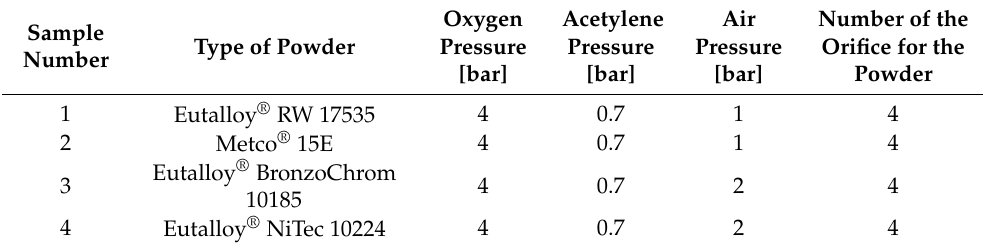
Table 6. Parameters of flame-sprayed Ni-Cr-B-Si and Ni-B-Si coatings using CastoDyn DS 8000 torch.